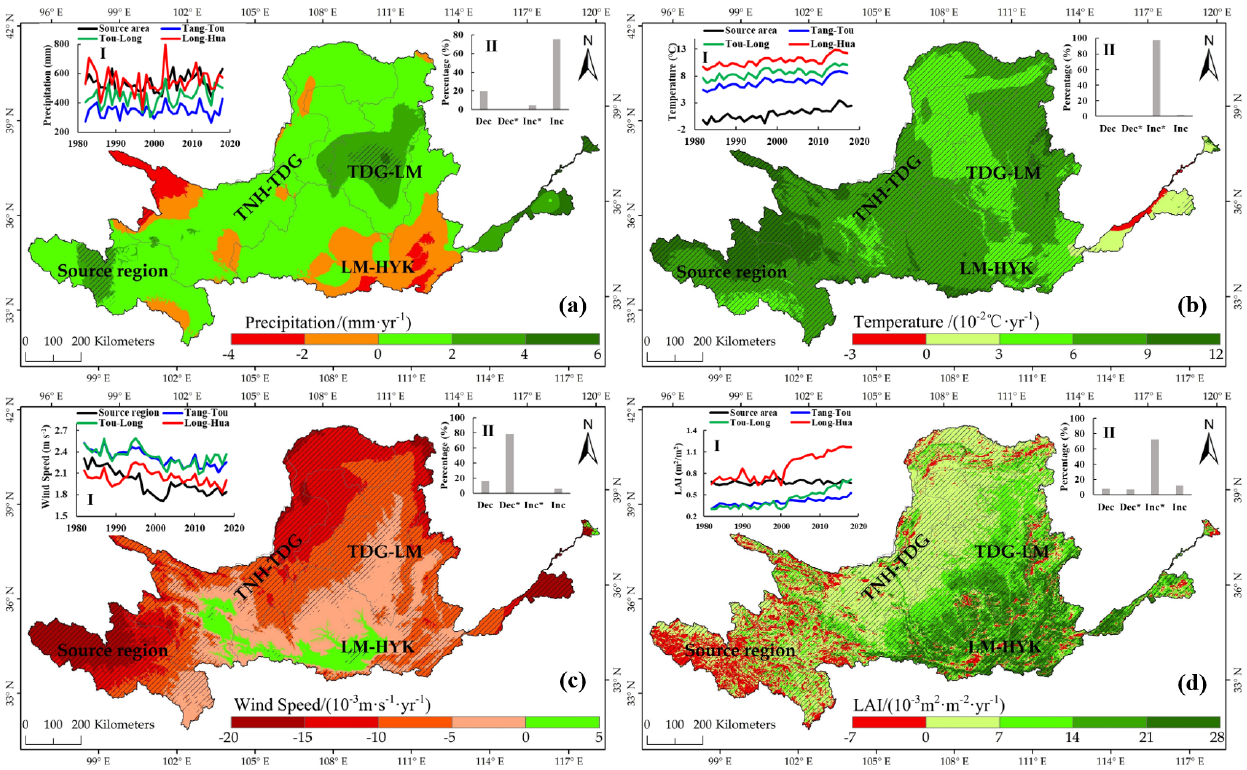
Figure 4. The spatiotemporal change of climate variables in (a) precipitation, (b) temperature, (c) wind speed, and (d) and LAI. Inset I in each panel shows the interannual variation of region-averaged variables. Insets II in each panel shows the percentages (%) of the area with significant decrease (Dec ∗ , p < 0 . 05), insignificant decrease (Dec), insignificant increase (Inc), and significant increase (Inc ∗ , p < 0 .